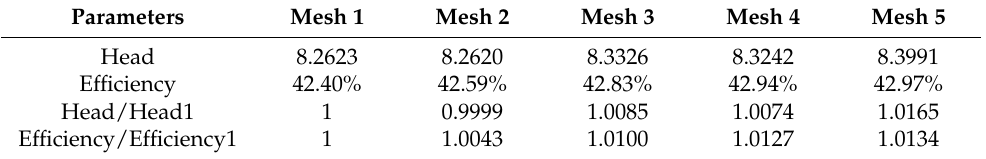
Table 4. Mesh independence verification.